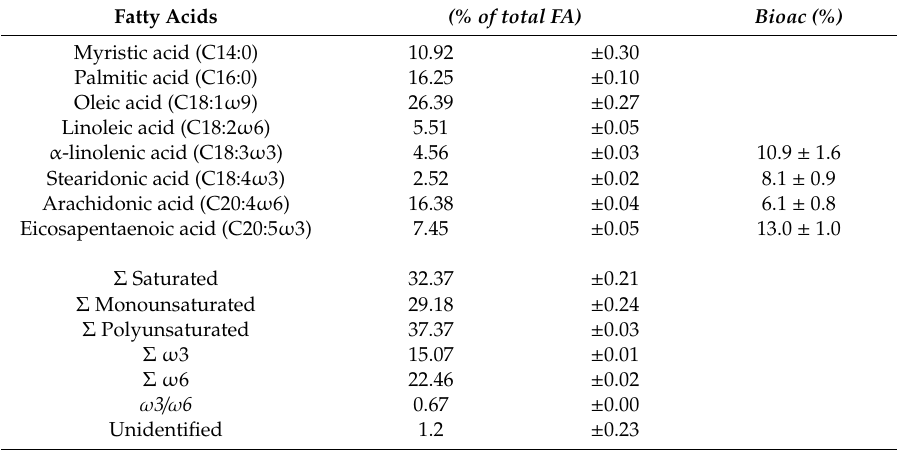
Table 1. Major fatty acids (FA) detected in freeze-dried (FD) F. spiralis (% of total fatty acids) and major fatty acids bioaccessibility (Bioac) percentages from freeze-dried F. spiralis . Values are mean ± SD.